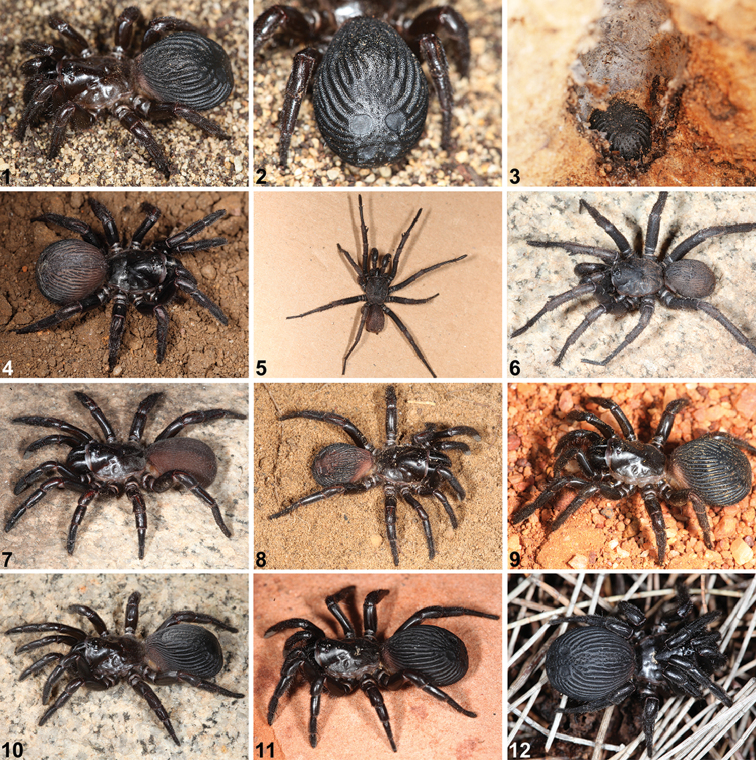
Live habitus images of shield-backed trapdoor spiders of the Idiosoma
nigrum-group. 1–3 Female I.
nigrum Main, 1952 (WAM T132737) from Minnivale Nature Reserve (Western Australia) 4 Female I.
sigillatum (O. P.-Cambridge, 1870) (WAM T129191) from Karnup, Perth (Western Australia) 5 Male I.
sigillatum (WAM T132564) from Crawley, Perth (Western Australia) 6 Male I.
sigillatum (WAM T136936) from Wangara (Western Australia) 7 Female I.
jarrah (WAM T136937) from Darlington (Western Australia) 8 Female I.
mcclementsorum sp. n. (WAM T139469) from Julimar State Forest (Western Australia) 9 Female I.
kopejtkaorum sp. n. from Charles Darwin Nature Reserve (Western Australia) 10 Female I.
schoknechtorum sp. n. (WAM T140765) from SW. of York (Western Australia) 11–12 Female I.
arenaceum sp. n. (WAM T141118) from Kalbarri National Park (Western Australia). Images 1–3, 6, 7, 9–12 by M. Harvey; 4 by Greg Anderson, used with permission; 5, 8 by M. Rix.